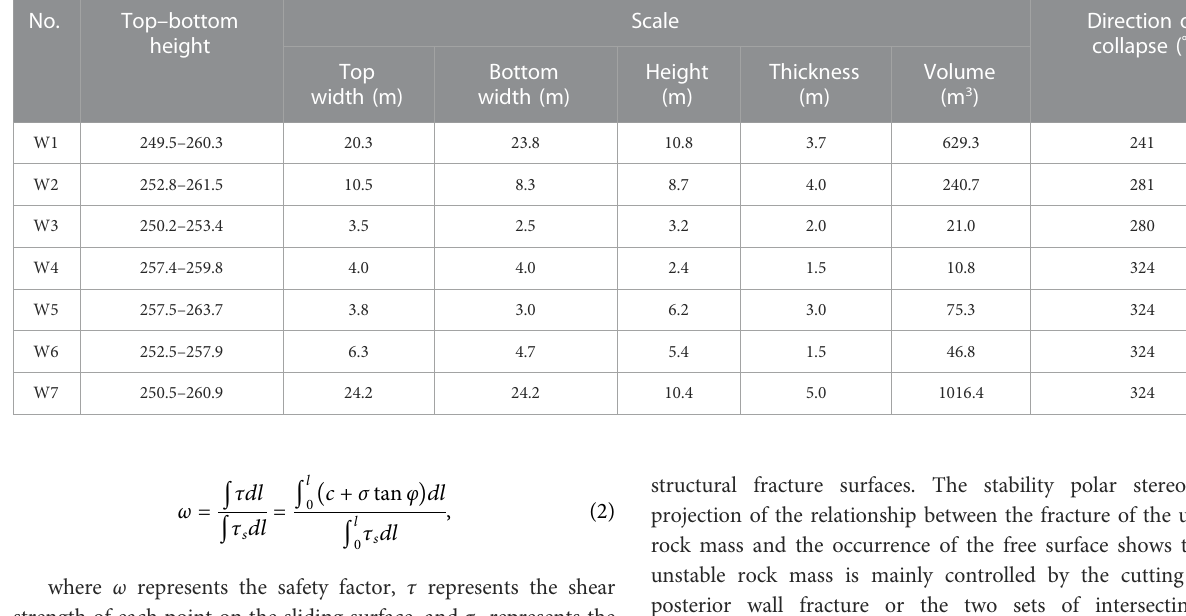
TABLE 2 Essential feature of unstable rock mass.